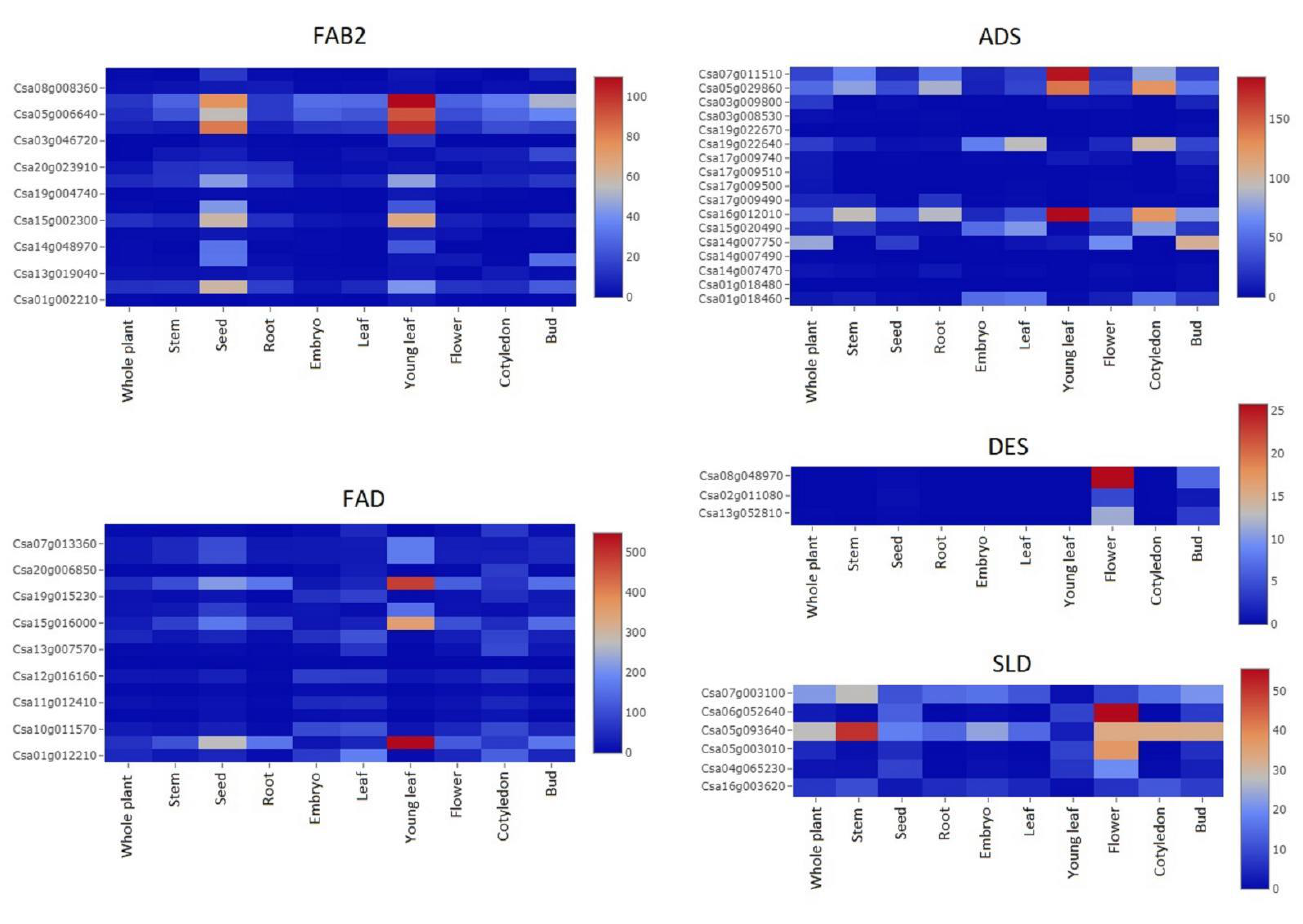
Figure 4. Expression pattern of fatty acid desaturase genes in C. sativa.